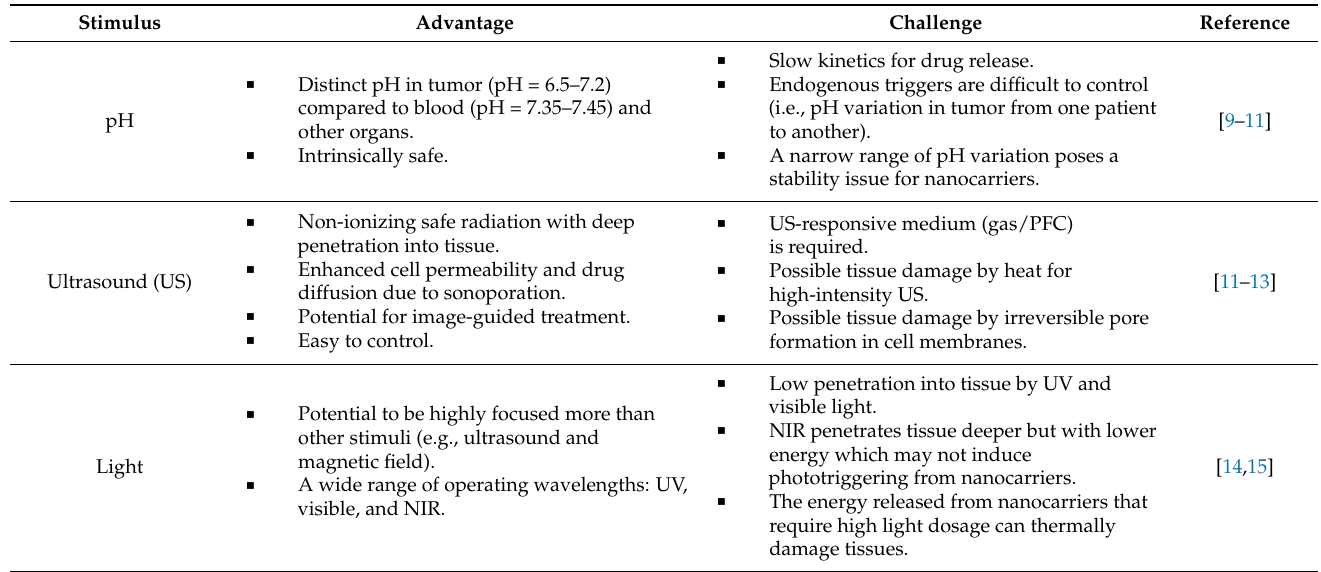
Table 1. Advantages and challenges of triggering stimuli used in drug